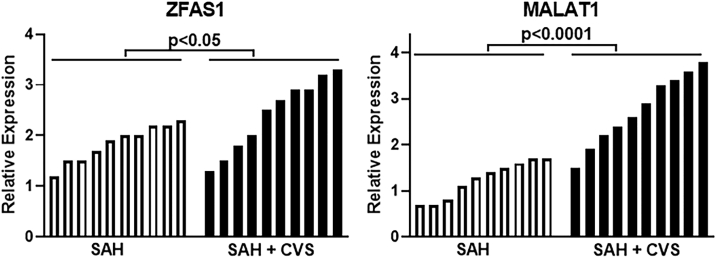
Expression of ZFAS1 and MALAT1 in Individual Patient SamplesExpression levels of lncRNAs ZFAS1 and MALAT1 in individual samples representing patients with SAH (without CVS) and those with SAH and CVS. Values plotted are mean ± 95% CI.